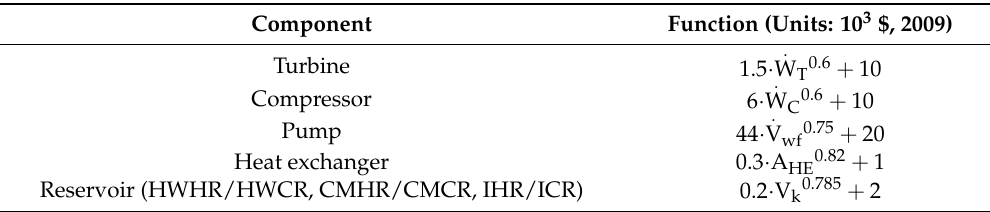
Table 4. Cost functions for the